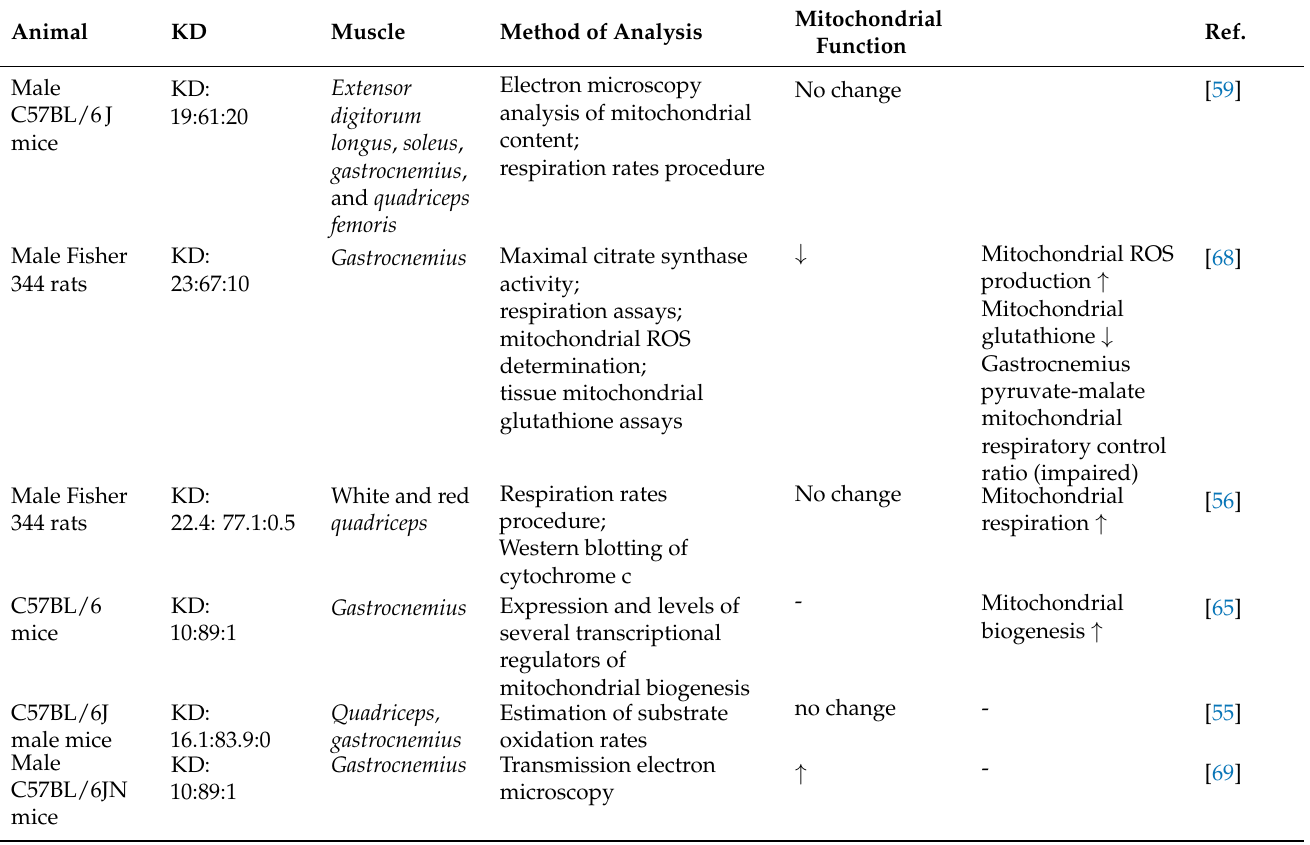
Table 2. Influence of KD on mitochondrial content and function in skeletal